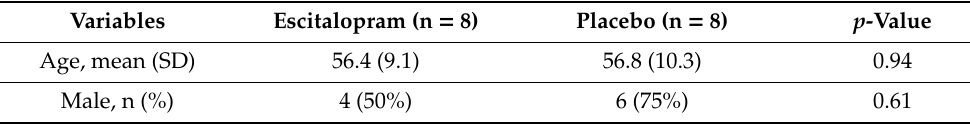
Table 1. Baseline